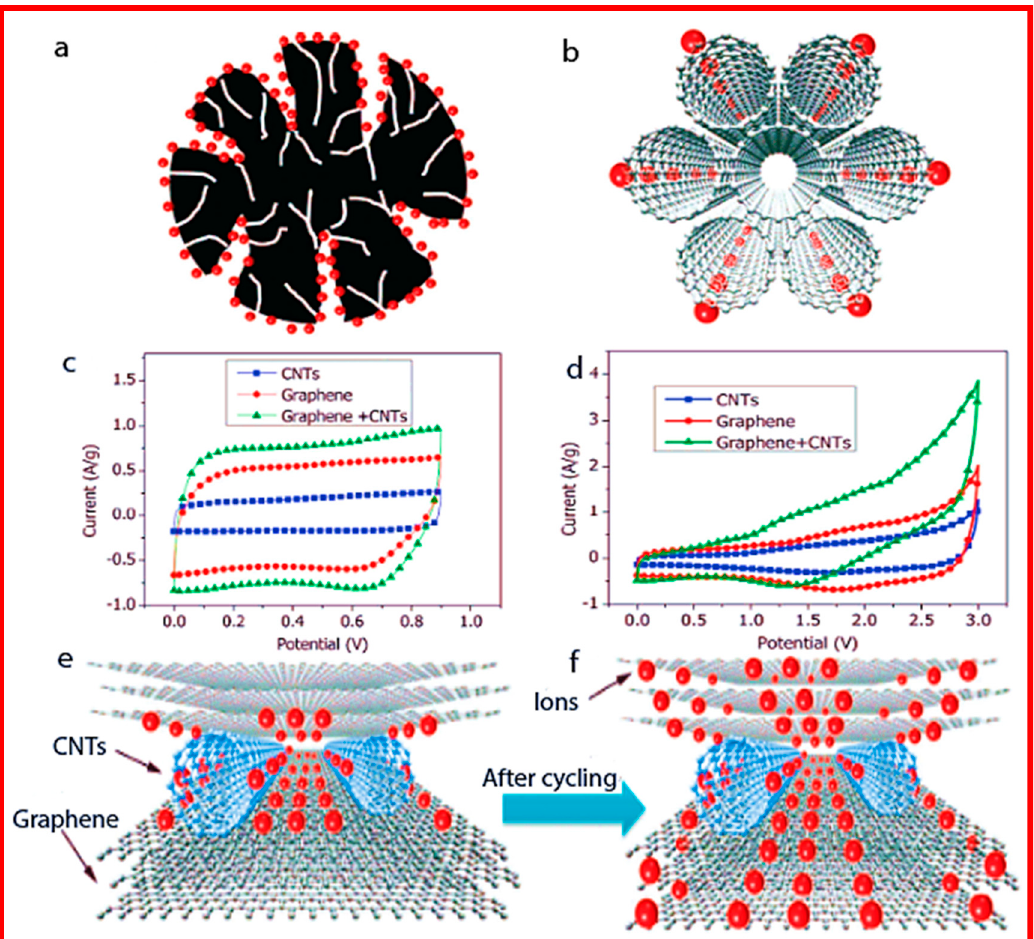
Figure 7. AC with high surface area; however, most of the micropores surface is not available for the electrolyte ions. ( a ) Single-walled carbon nanotube (SWCNT). ( b ) Cyclic voltammograms (CVs) for di ff erent electrode materials made of CNTs, graphene, and their composite in the aqueous electrolyte at a scan rate of 10 mV · s − 1 ( c ), CVs for the same material as part (c), but in a di ff erent electrolyte (1 M TEABF4 / PC electrolyte) at the same scan rate of 10 mV · s − 1 . ( d ) The illustration of the electro-activation phenomenon to improve the electrode surface area after charging–discharging cycles: Graphene layers before cycling, which are tending to restack. ( e ) After a long cycle life, the intercalated ions separated the graphene sheets, thus increasing the surface area accessible for electrolyte ions, and consequently an enhancement in the capacitive property of the material. ( f ) Reprinted with permission from [108], Copyright 2011, Royal Society of